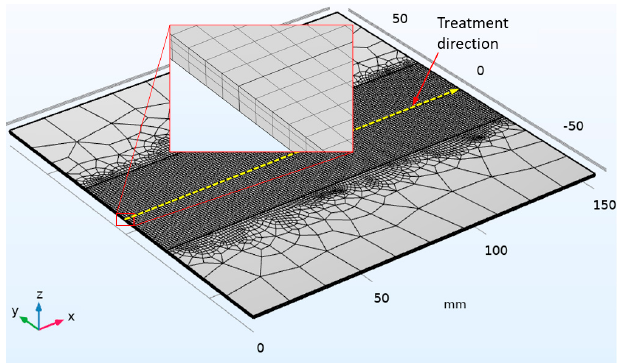
Figure 2. Mesh distribution in the blank.